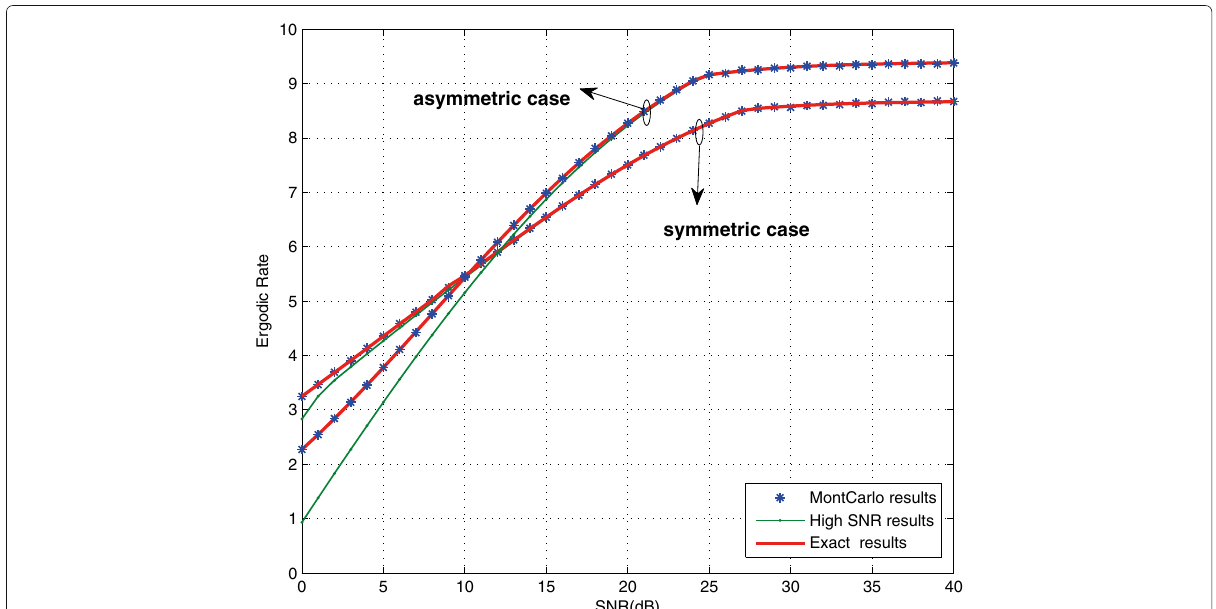
Fig. 3 Exact ergodic rate, high SNR approximations, and Monte-Carlo simulated ergodic rate for both asymmetric and symmetric cases of D2D communication assisted by two-way DF relay node